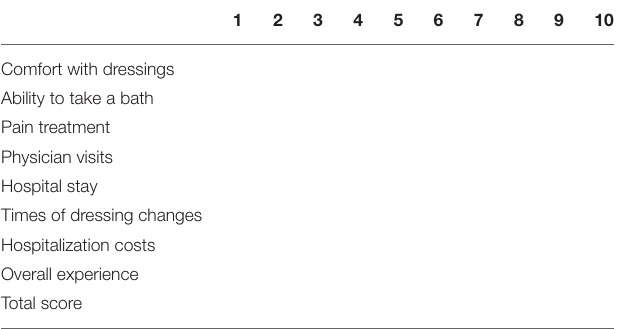
TABLE 1 | Satisfaction record table. TABLE 2 | Demographic characteristics of the